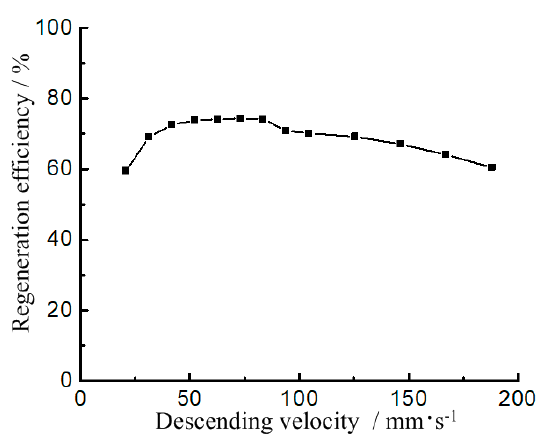
ffi ciency under a di ff erent load Figure 19. Curve of regeneration efficiency under a different load velocity. Figure 19. Curve of regeneration e